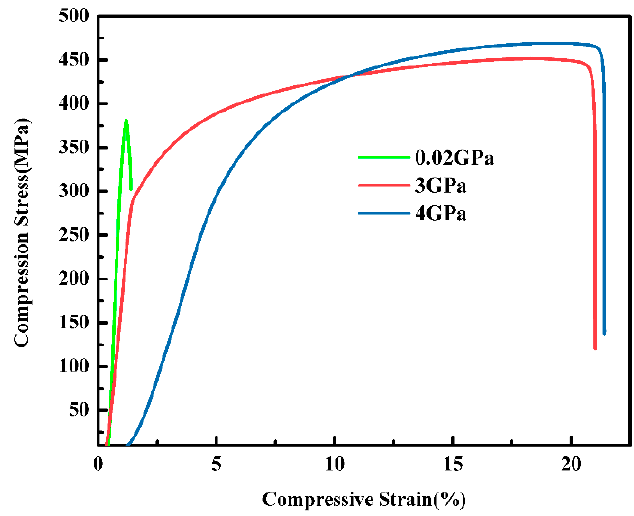
Figure 7. Composite compressive of Al 2 O 3 /Al-20Si composite.